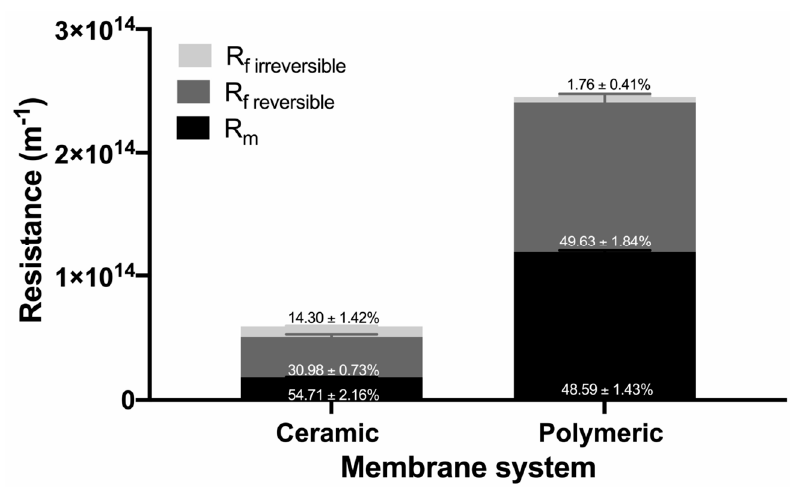
Figure 7. Calculated resistances of the membrane systems—reversible and irreversible fouling.